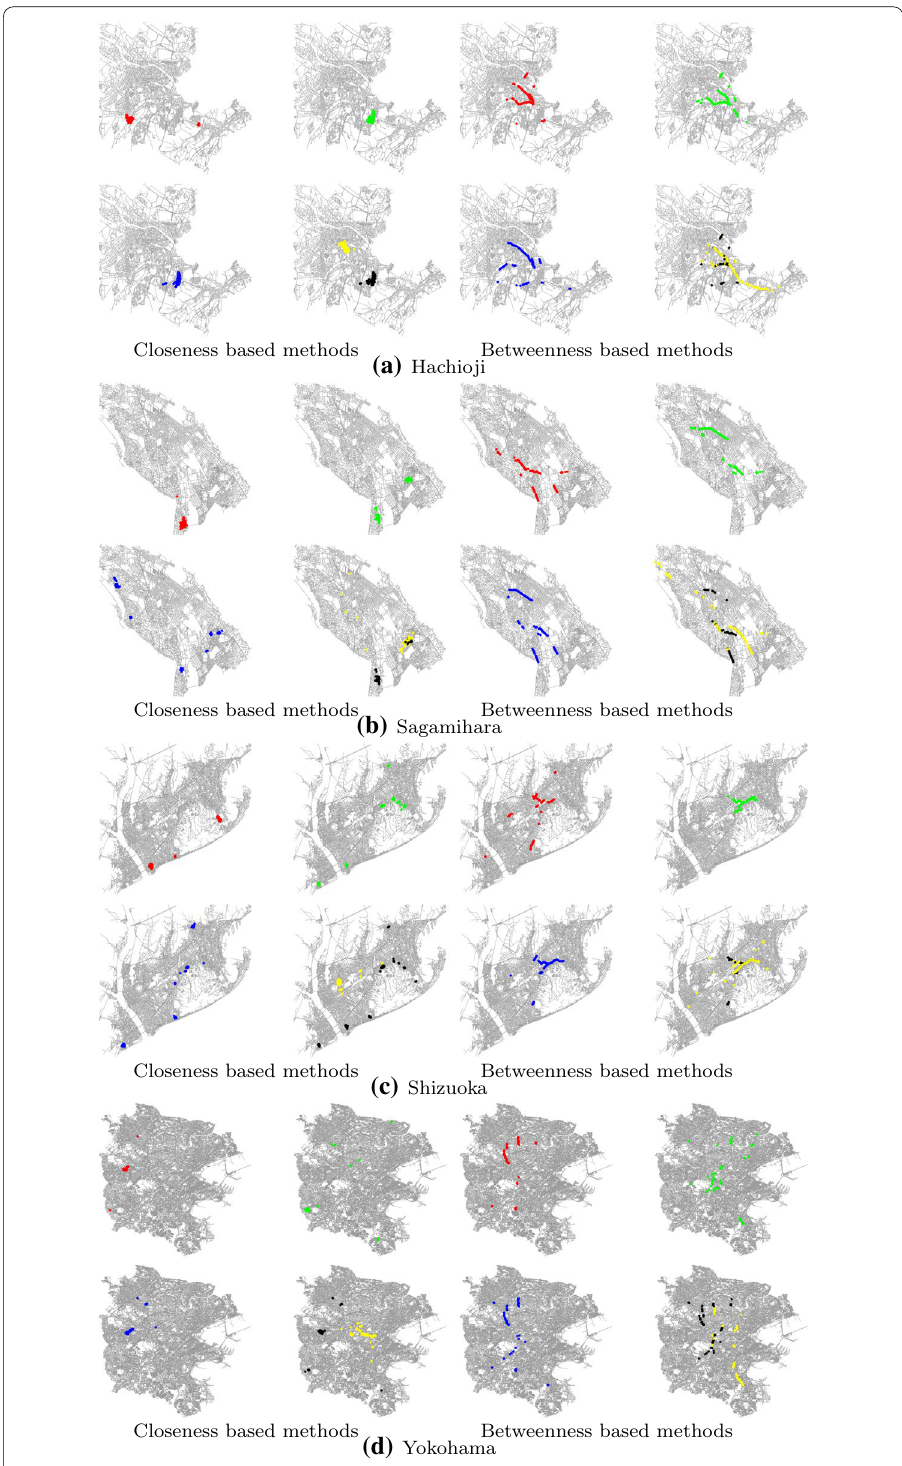
Fig. 9 Extracted top 100 nodes: The red, green, and blue dots represent top nodes by proposed methods, MPCLC and MPBWC, for g1, g2, and g3, respectively. The black dots represent top nodes by compared methods, SPCLC and SPBWC. The yellow dots represent top nodes by methods, CLC and